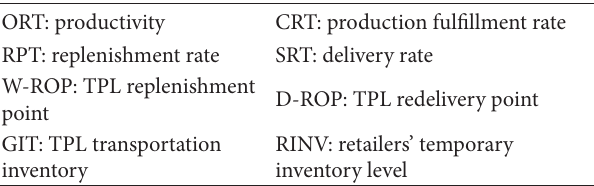
Table 3: Definitions of parameters and